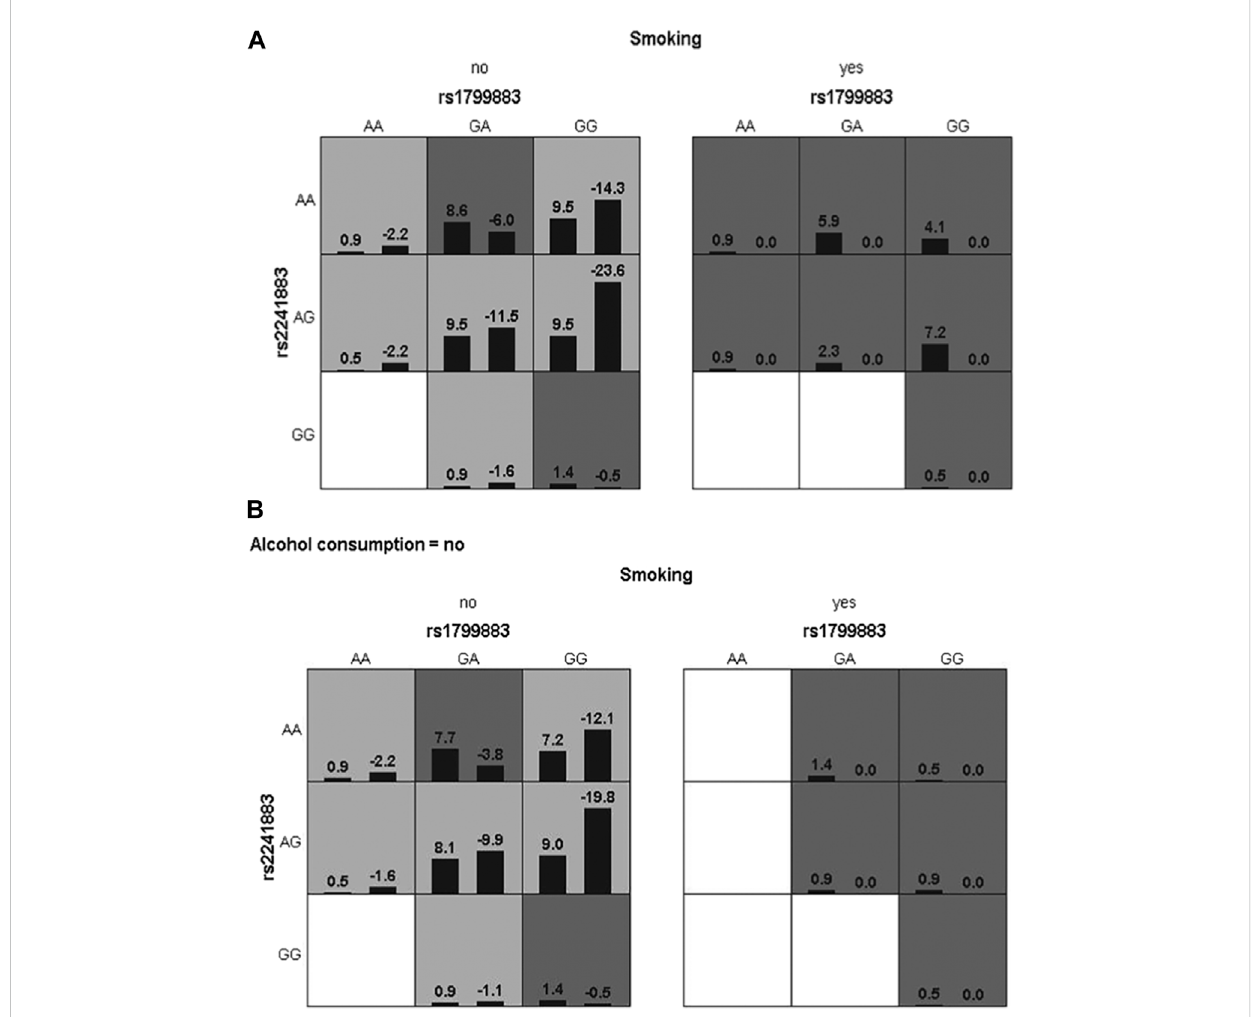
FIGURE 4 The optimal interaction model of genes and environmental factors. (A) Interaction between two genes and smoking. (B) interaction between two genes and smoking and alcohol